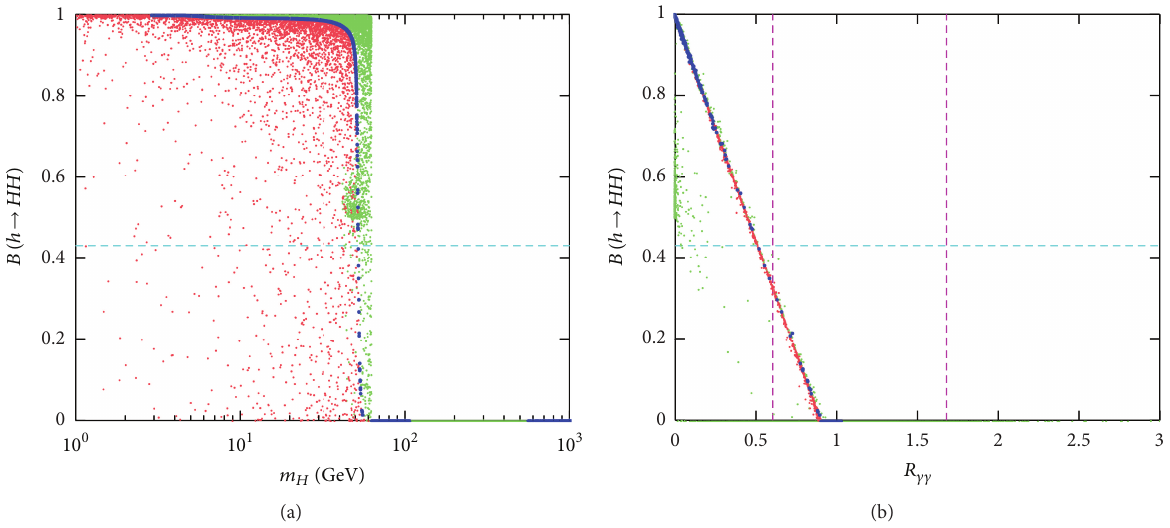
Figure 5: Branching ratio for the invisible decay of the SM-like Higgs boson as a function of the DM candidate mass 𝑚 𝐻 (a) and as a function of the parameter 𝑅 𝛾𝛾 (b), for the same random scan of IHDM parameter space. Please note that there is a number of points on the 𝑚 𝐻 and 𝐵(ℎ → 𝐻𝐻) = 0 . 𝑅 𝛾𝛾 axes, with